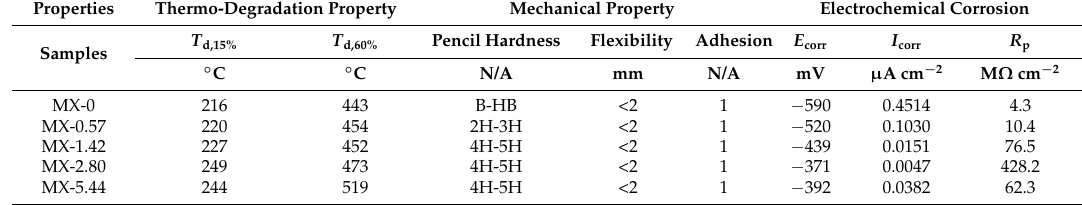
Table 2. Thermal, mechanical, and electrochemical corrosion properties of MX-0–MX-5.44.